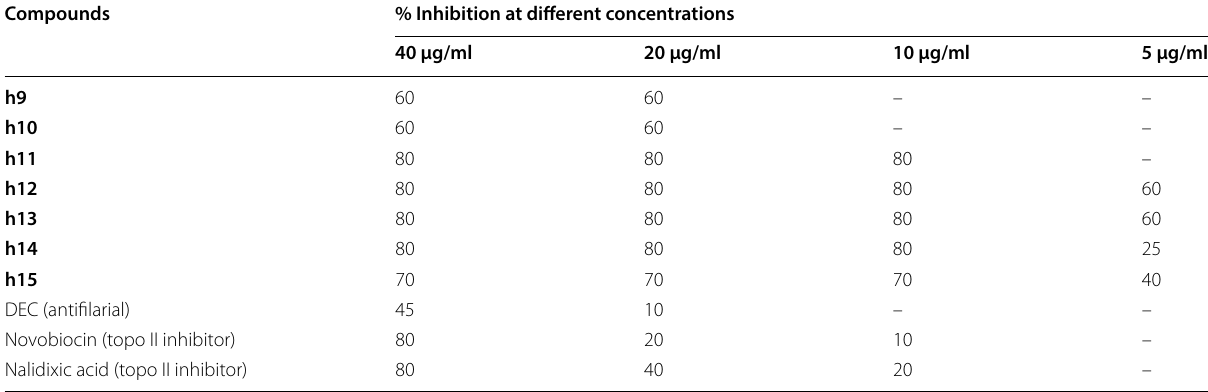
Table 52 Topoisomerase II inhibitory activity against filarial parasite Setaria cervi Compounds % Inhibition at different concentrations